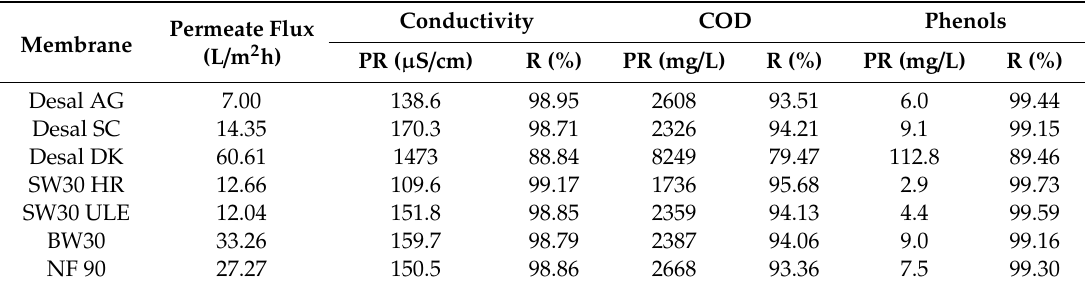
Table 6. Results of the RO screening tests with different types of NF and RO membranes (P = 30 bar, T = 25 °C). Feed: MF permeate of OMW2-CA (Conductivity = 13,200 µS/cm; COD = 40,180 mg/L; Phenols = 1070 mg/L).